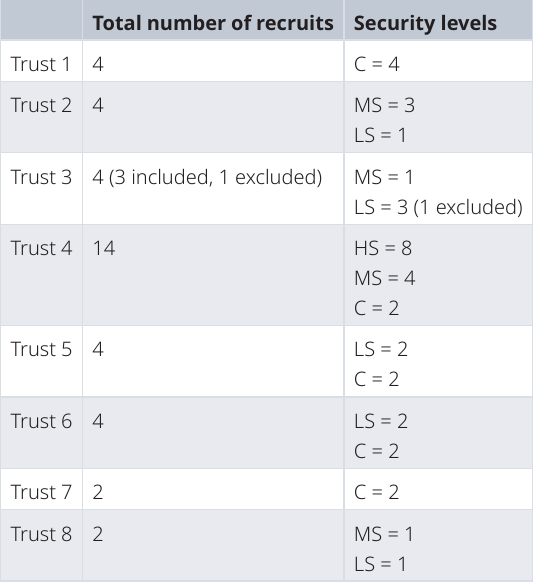
Table 1. Number of recruits by participating NHS